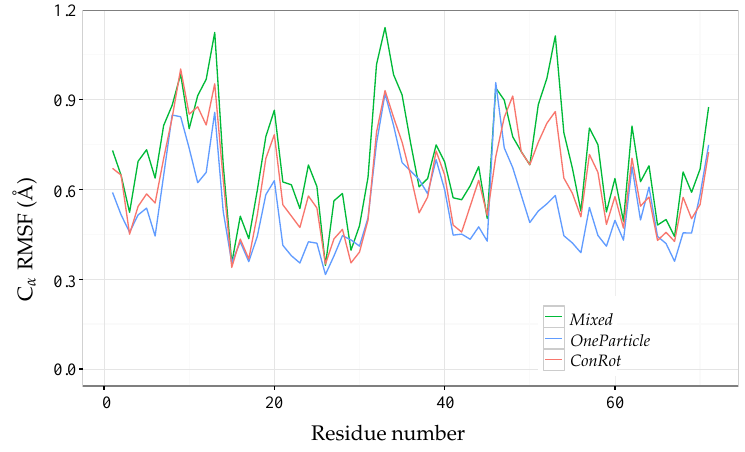
10 6 steps of MC simulations using ConRot , OneParticle , and ×